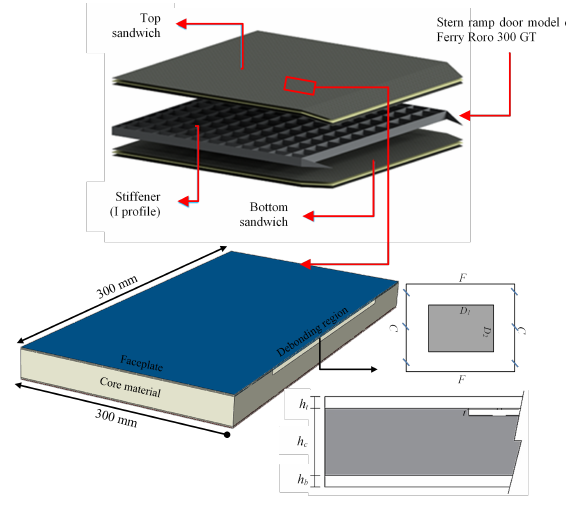
Figure 1: Sandwich geometry with debonding [21].